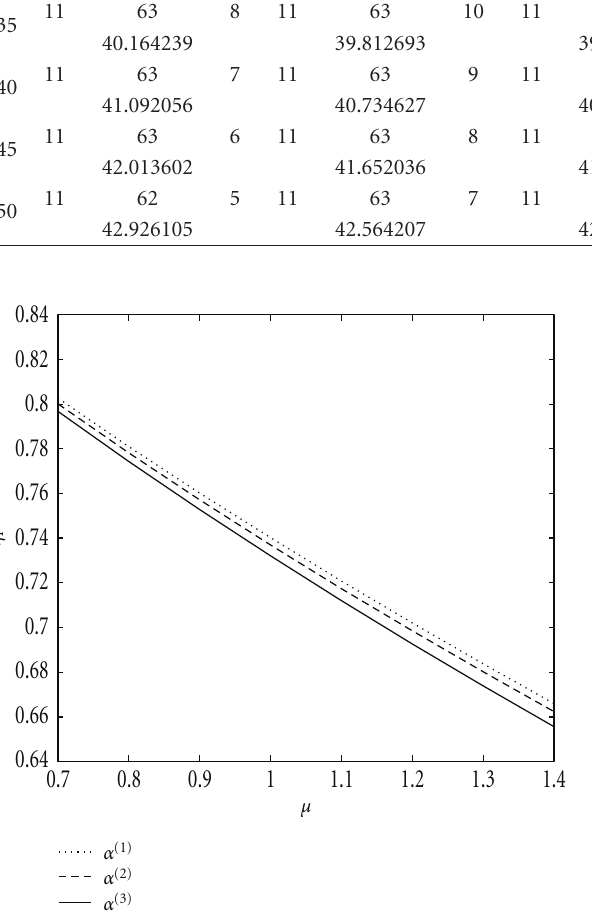
Figure 4: Fraction of time server is on vacation— μ versus α ( n ) ( S = 90, s = 15, N = 25, β = 1 . 4, γ = 4, λ = 8, p = 0 . 75 . )